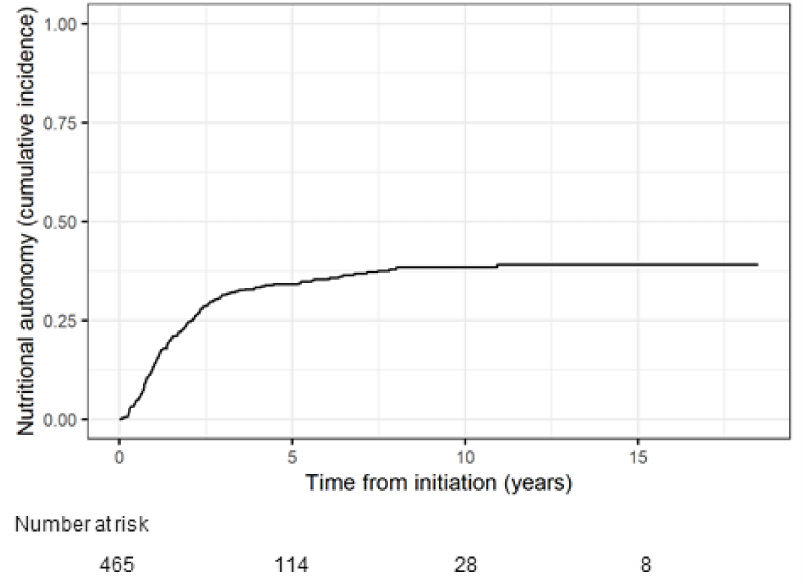
Figure 2. Cumulative incidence function of achieving nutritional autonomy.